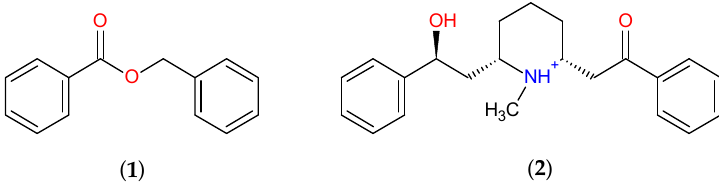
Figure 10. Promising molecules ZINC00001021 ( 1 ) and ZINC00001624 ( 2 ) obtained after virtual screening.